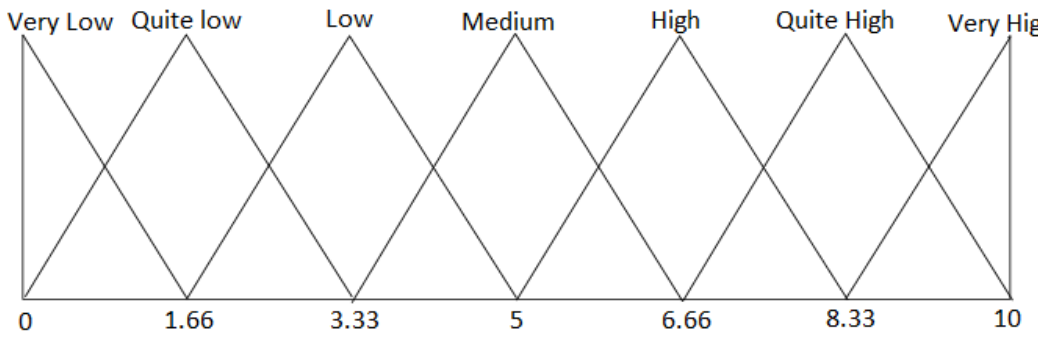
Figure 1. Representation of the linguistic variable Acidity